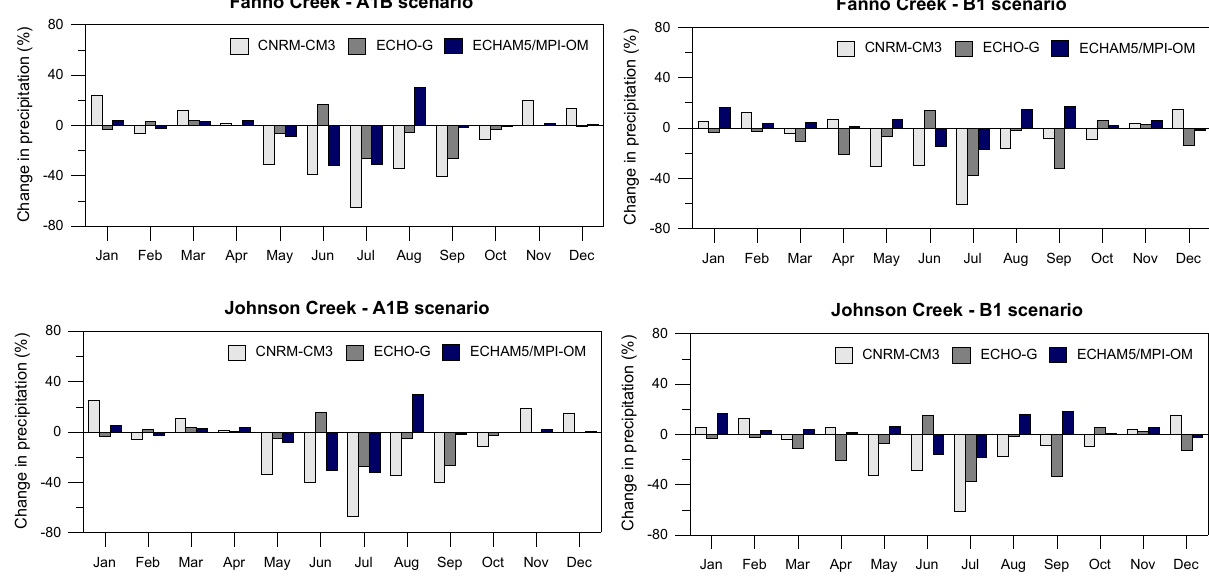
Fig. 4. Changes in precipitation according to three GCMs and two emission scenarios in Fanno Creek and Johnson Creek catchments.